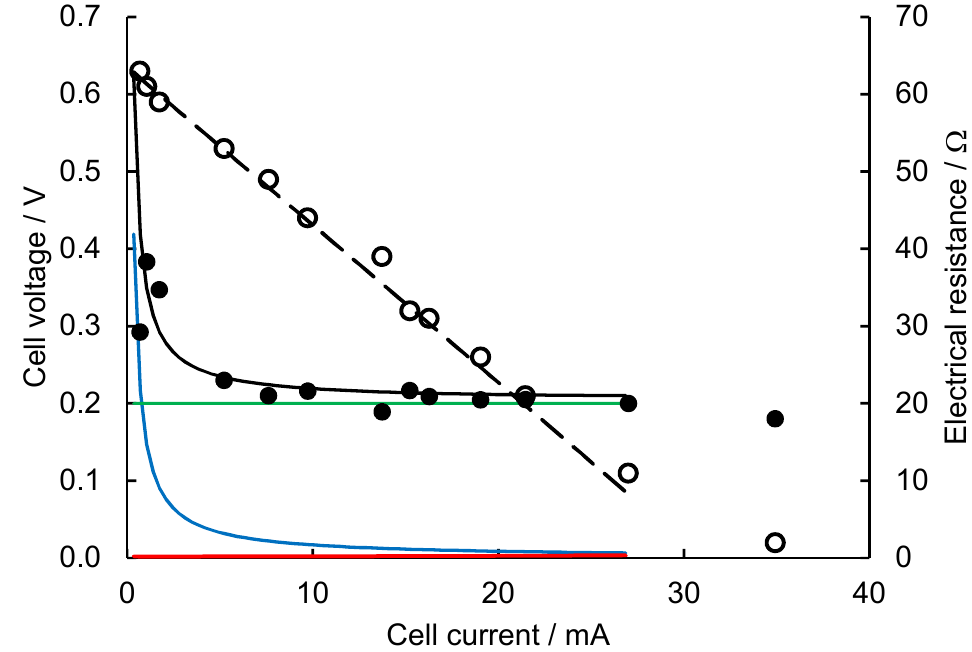
Figure 1. Polarization curve (o) adapted from [27]. Predictions of polarization curve (dashed line), R i (solid black line), R act (solid blue line), R conc (solid red line), and R ohmic (solid green line). R i ( • ) evaluated from Equation (9).